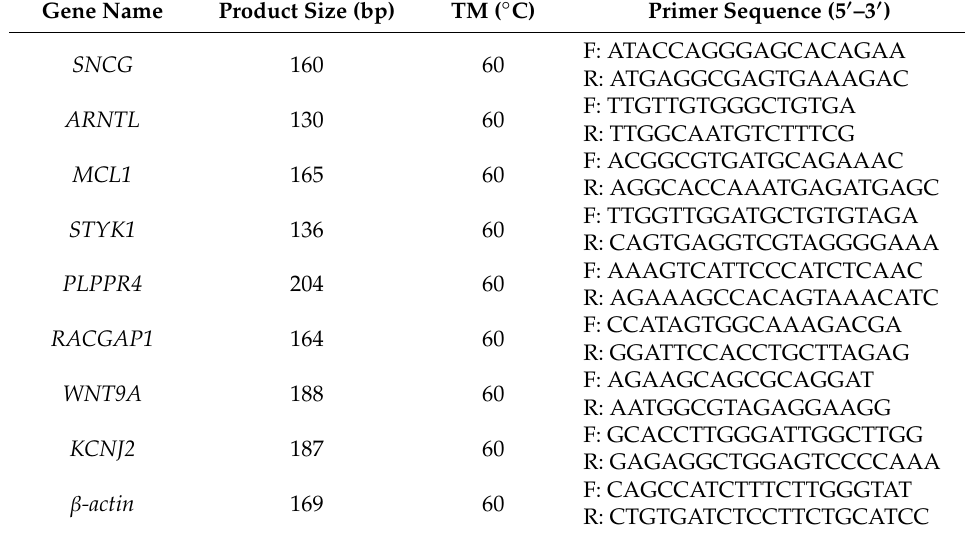
Table 1. Primers for quantitative real-time PCR (QRT-PCR).